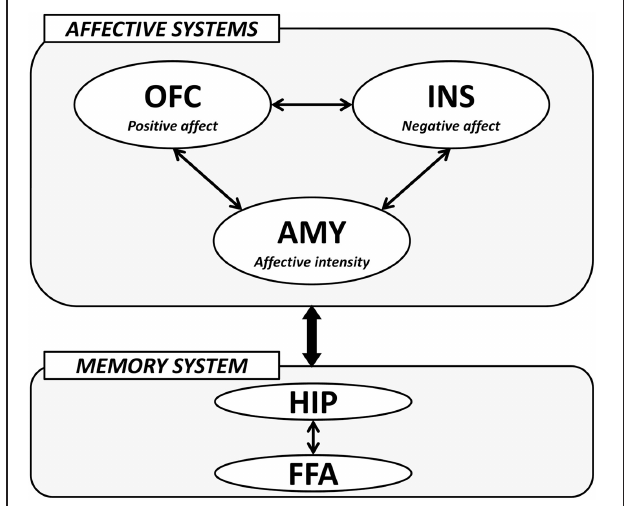
FIGURE 4 | A hypothetical model of the neural mechanisms underlying the effect of face-based affective signals on memory for faces. AMY, amygdala; OFC, orbitofrontal cortex; INS, insular cortex; HIP, hippocampus; FFA, fusiform face